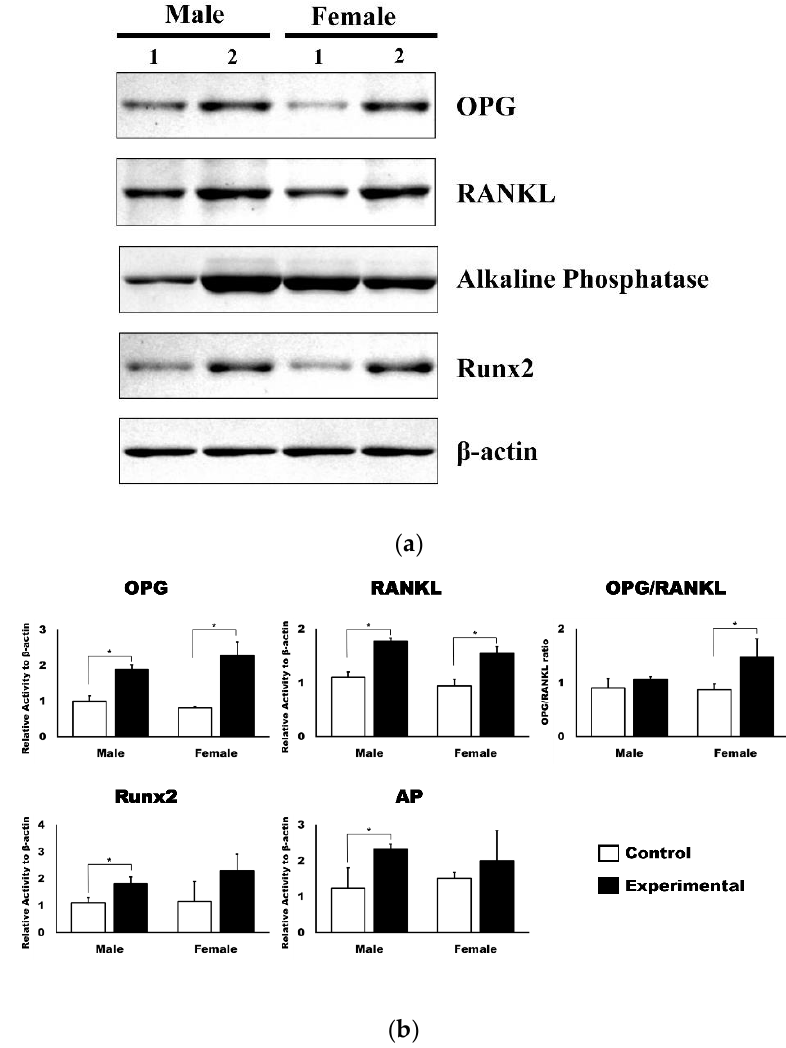
Figure 4. The results of Western blot for tissue samples. ( a ) The representative blot images after 4-hexylresorcinol (4HR) administration. Compared to that in the control group, the administration of 4HR increased the expression of OPG, RANKL, alkaline phosphatase (AP), and Runx-2 (1: control; 2: experimental group). ( b ) Relative level of expression of β-actin for each protein was calculated. In addition, the OPG-to-RANKL ratio was calculated. When compared to the control group, the experimental group showed a significantly higher level of expression (* p < 0.05).